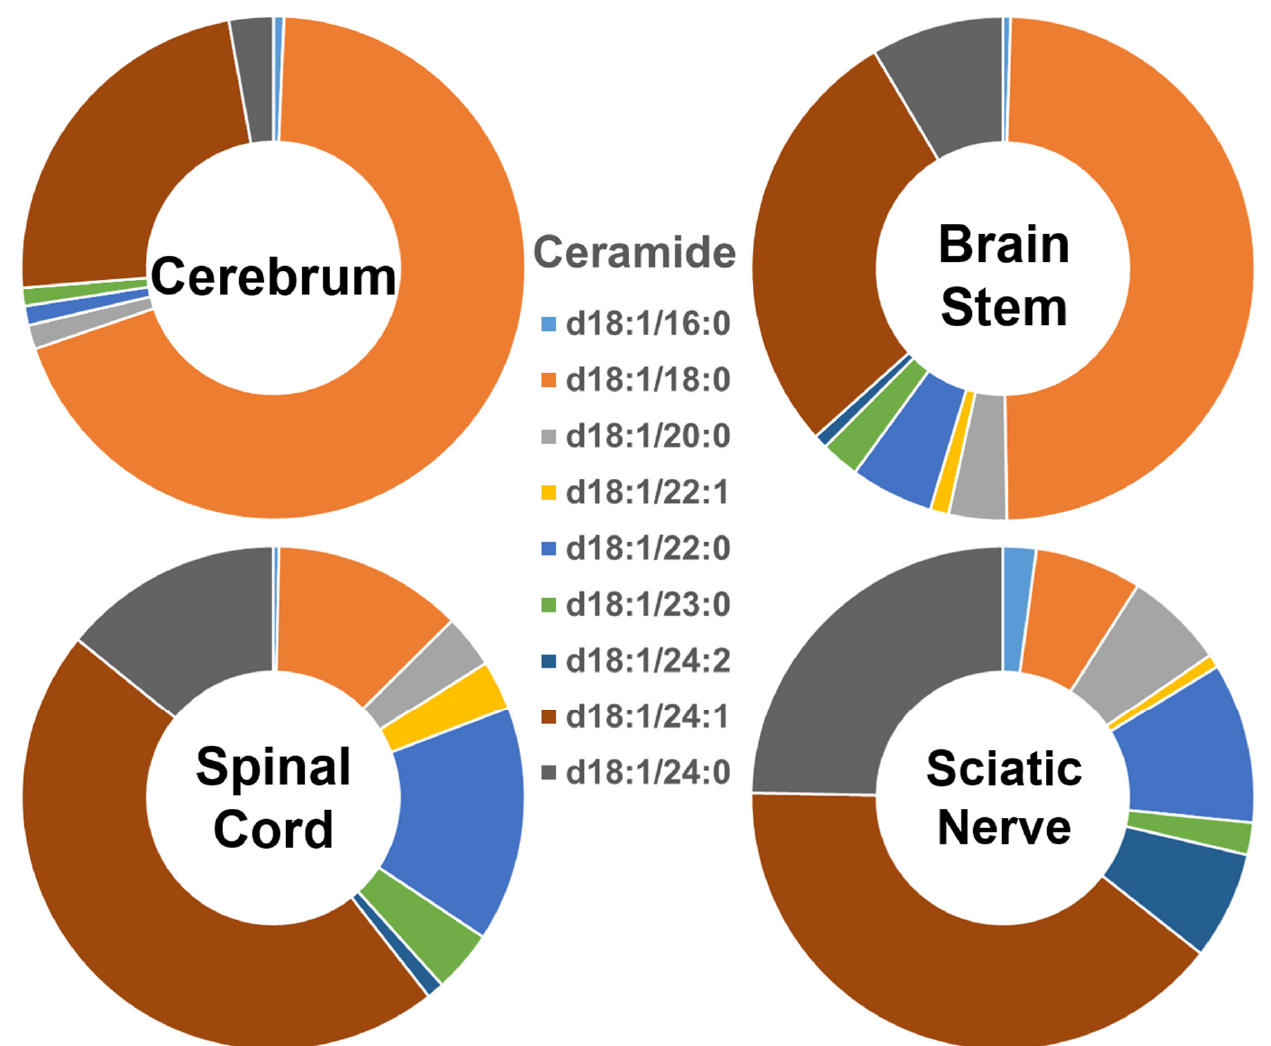
Figure 1. Comparison of ceramide molecular species profiles in cerebrum, brain stem, spinal cord, and sciatic nerve tissues from 2 mo-old mice. Levels of individual ceramide molecular species were assessed via shotgun lipidomics; the relative abundance of each species compared to the total class content is displayed in the form of pie graphs (Excel).